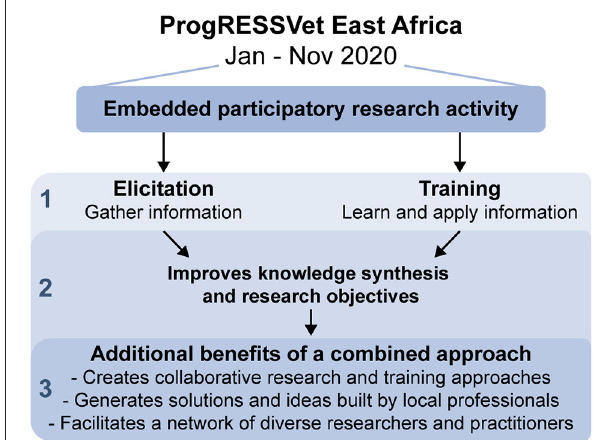
FIGURE 2 | Benefits of combined elicitation and training activity embedded within an education program. Level 1: Both objectives (elicitation and education) can be achieved within a single activity. Level 2: Each attribute (elicitation and education) of the activity enhances the other, contributing to improved achievement of each. For example, the coupling of the two activities enabled extended opportunities for subject-matter training and a relationship of mutual respect to be the foundation for the elicitation process. The participatory research activities reinforced knowledge synthesis objectives of the educational program. Level 3: The synergy between the two concurrent objectives may produce benefits which transcend either independent